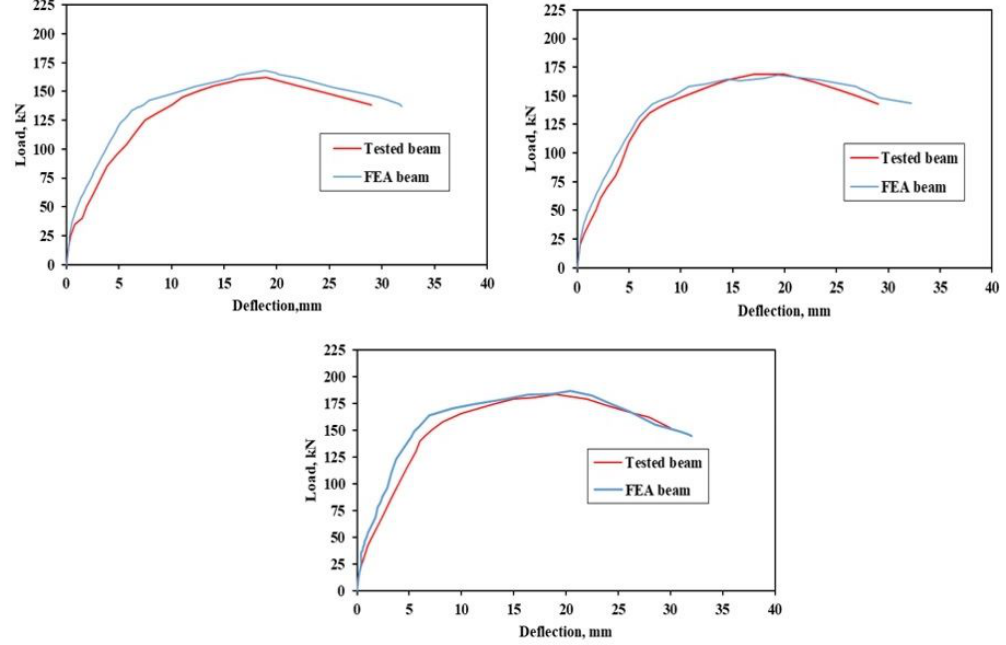
Figure 18: The experimental and numerical results of load-midspan deflection curves of the specimens PB3 (top left), PB4 (top right) and PB5 (bottom middle)